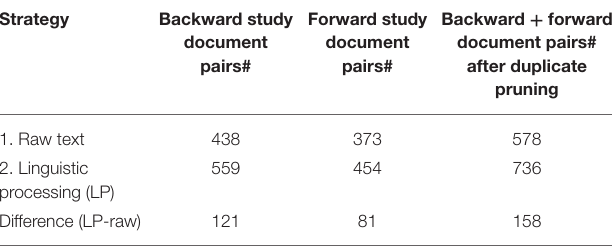
TABLE 10 | Comparison of the two strategies on the LREC corpus.